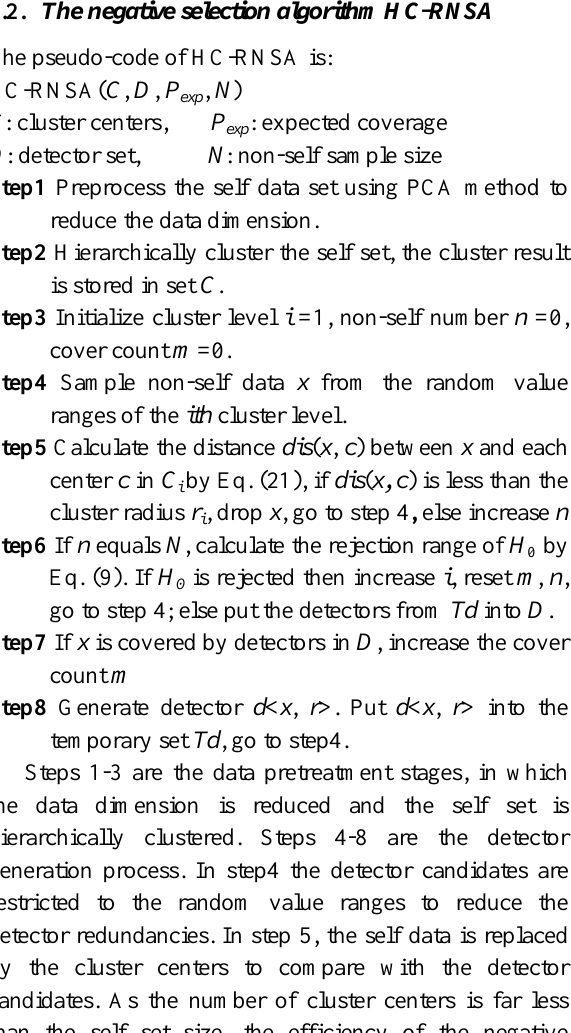
Fig. 3. The relationship between d and D max - D min under different distance